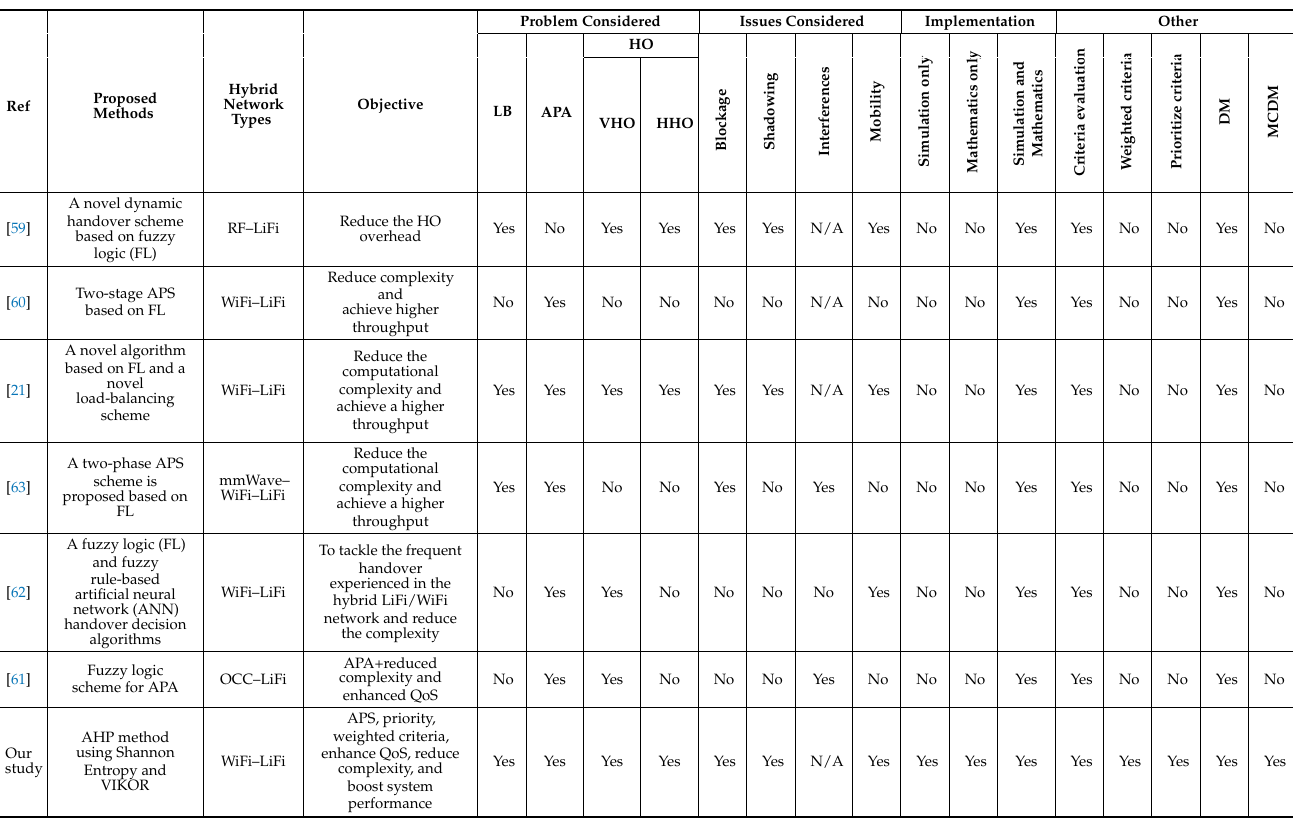
Table 1. Brief synopsis of related literature, including comparison to our own